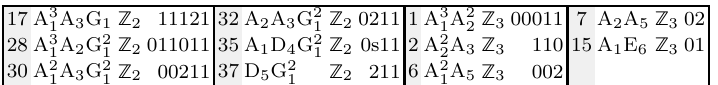
Table 11 . Groups of maximal rank with non-trivial fundamental group and their generators for the heterotic Z 3 triple.